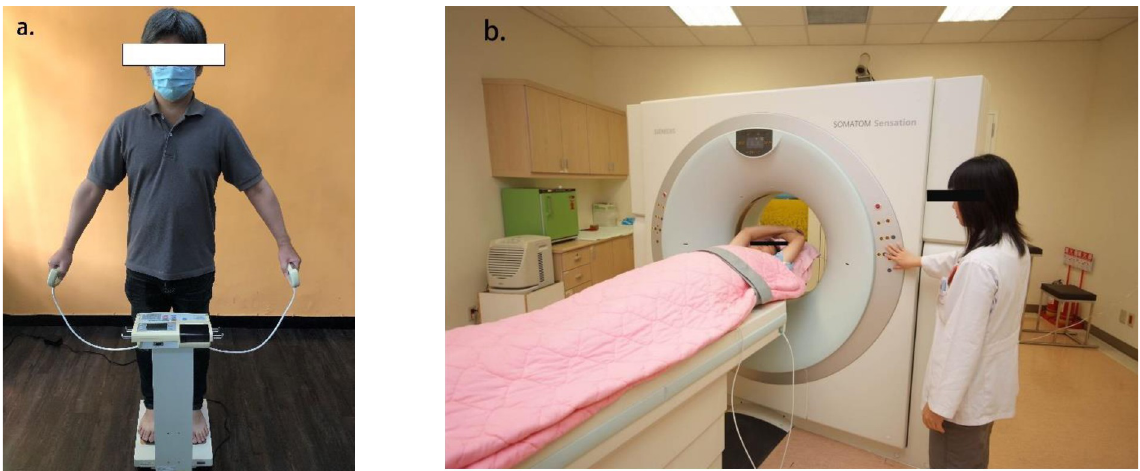
Fig 1. Impedance measurement and computed tomography. (a) Whole body impedance measurement with standing bioimpedance analyzer (Taitan BC418MA); (b) Cross-sectional scan of abdomen with Somatom Sensation 64 CT system.